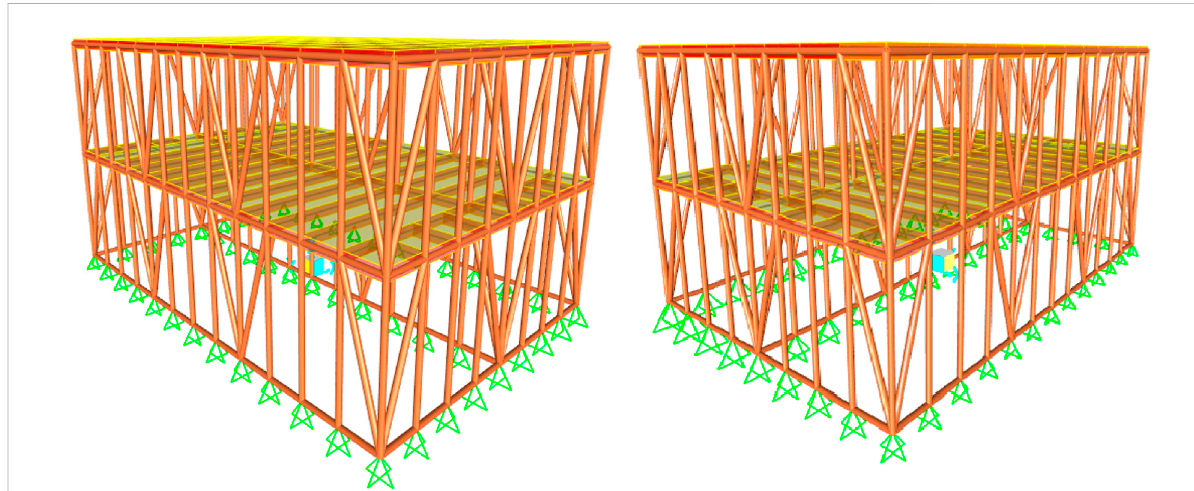
FIGURE 12 BaharequestructuremodeledinSAP2000.(Brownframeelements representGuaduacanes,shellelements represent fl oorslabs,andlightthin lines represent boundary conditions).